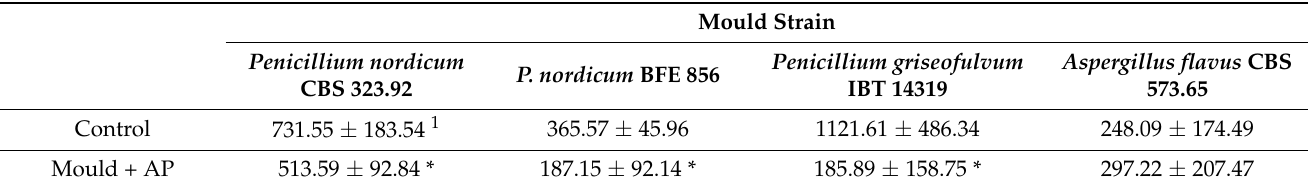
Table 4. Effect of an antifungal preparation (AP) on the ergosterol content ( µ g/g mycelium) of four toxigenic mould strains.